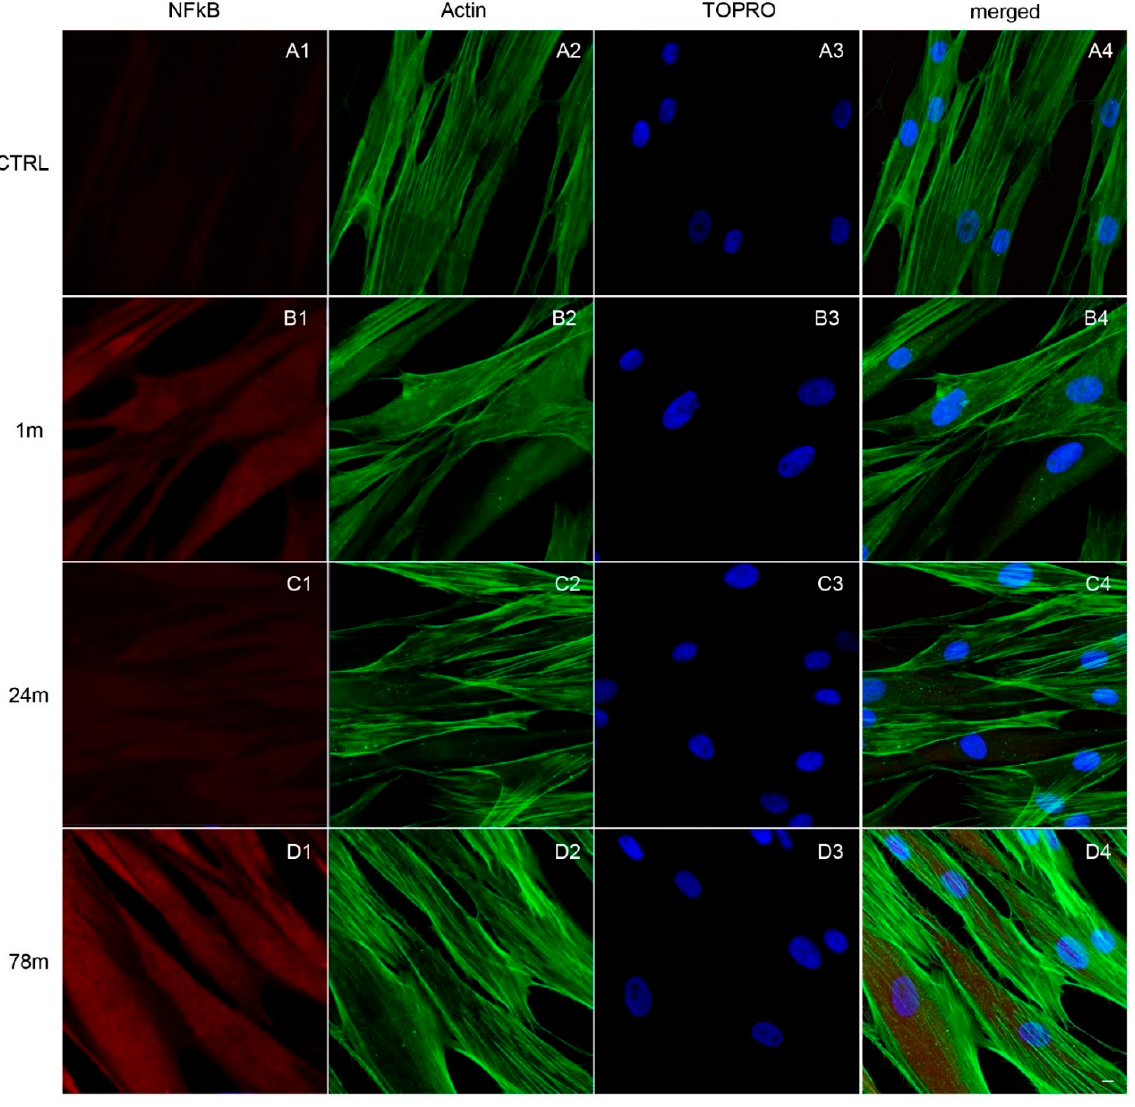
Figure 4. Immunofluorescence analysis of NFkB expression on ( A1 ) CTRL cells and on cells exposed to ( B1 ) 1, ( C1 ) 24 and ( D1 ) 78 m MPs. ( A1 – D1 ) Red fluorescence: cytoskeleton actin; ( A2 – D2 ) green fluorescence: NFkB; ( A3 – D3 ) blue fluorescence: cell nuclei; ( A4 – D4 ) merged image of the above-mentioned channels. Scale bar: 20 μ m.